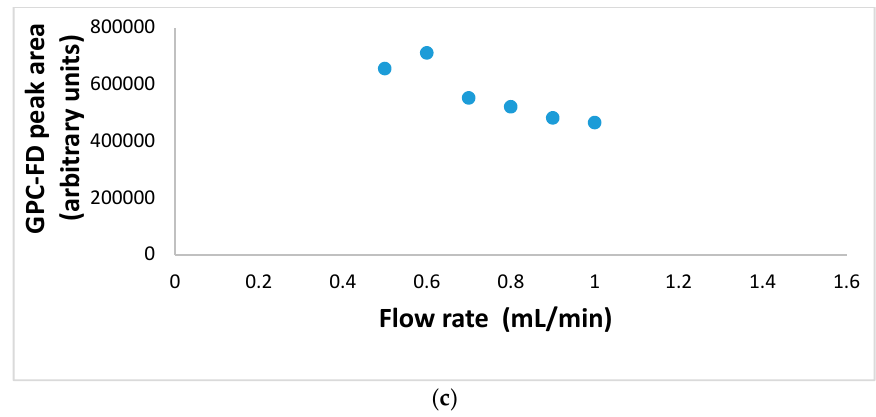
Figure 7. Effects of flow rate on ( a ) retention time, ( b ) retention volume, and ( c ) peak area of lecithin liposome-encapsulated TiO 2 nanoparticles (0.01 mg/mL) in extend GFC analysis, using λ ex,max = 350 nm and λ em,max = 395 nm for FD.